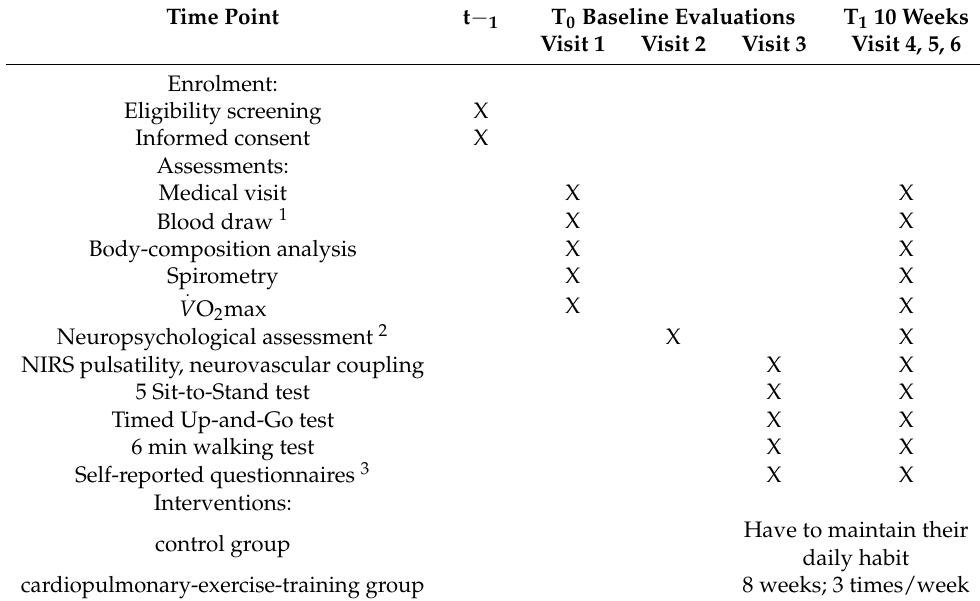
Table 1. Enrolment, assessments and interventions according to SPIRIT